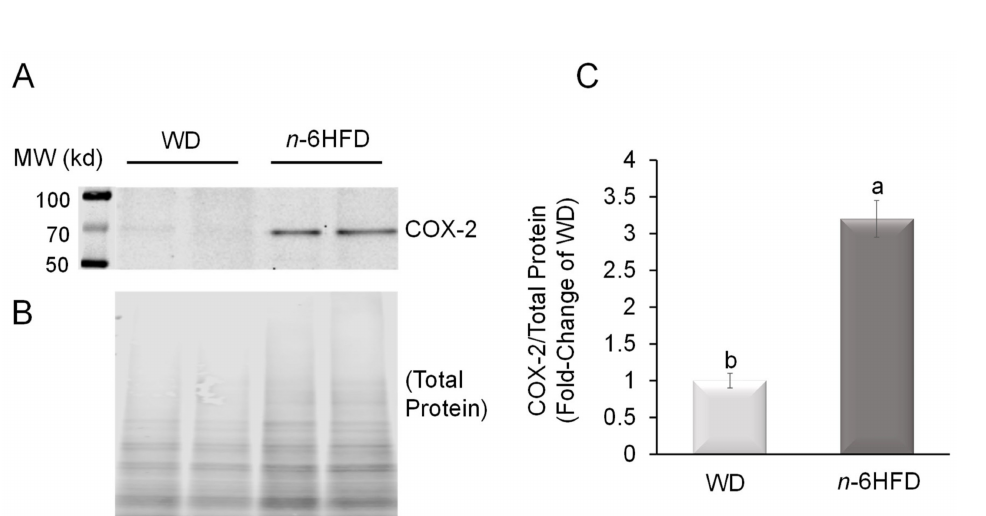
Figure 4. An n -6HFD induces COX-2 expression in colonic mucosa. ( A ) Western blot for COX-2 in protein extracts from intestinal mucosa of two representative 16-weeks-old C57BL/J6 male mice fed the WD or n -6HFD. ( B ) Total protein staining control. ( C ) Bars are average fold-change levels ± SEM of COX2 protein expression. Means with different letters differ ( p < 0.05, n =